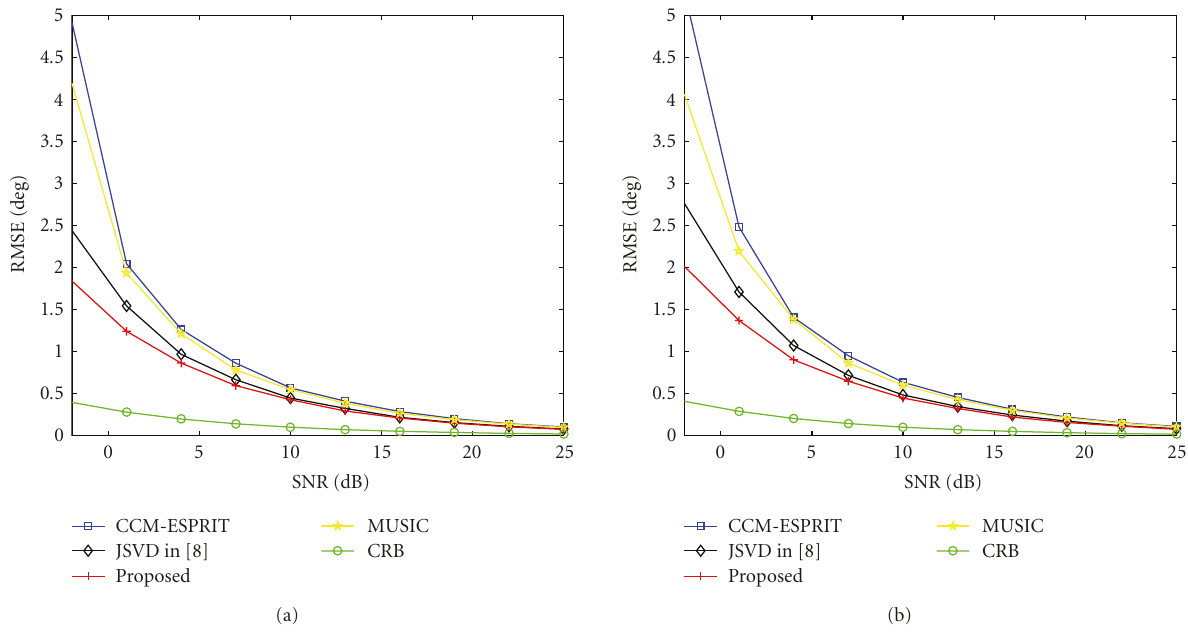
Figure 3: JRMSE of joint elevation and azimuth angle estimation versus SNR for two uncorrelated sources with equal power at the DOA: (a) (45 ◦ , 110 ◦ ) and (b) (55 ◦ , 100 ◦ ).